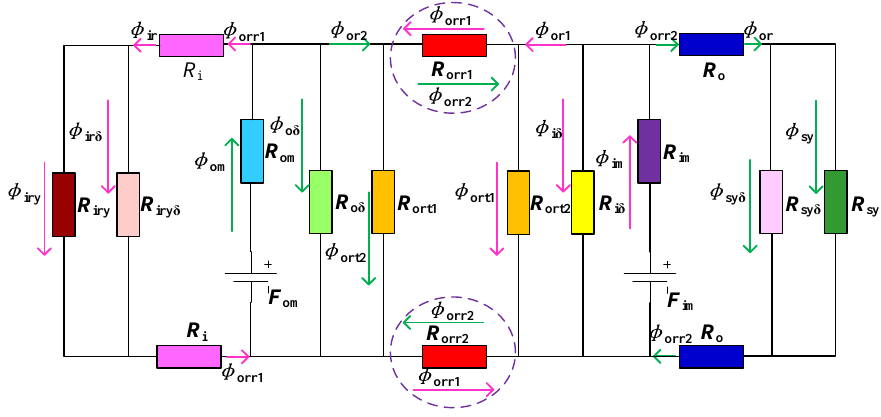
and radial magnetic fluxes in the outer rotor is described in Figure 8.